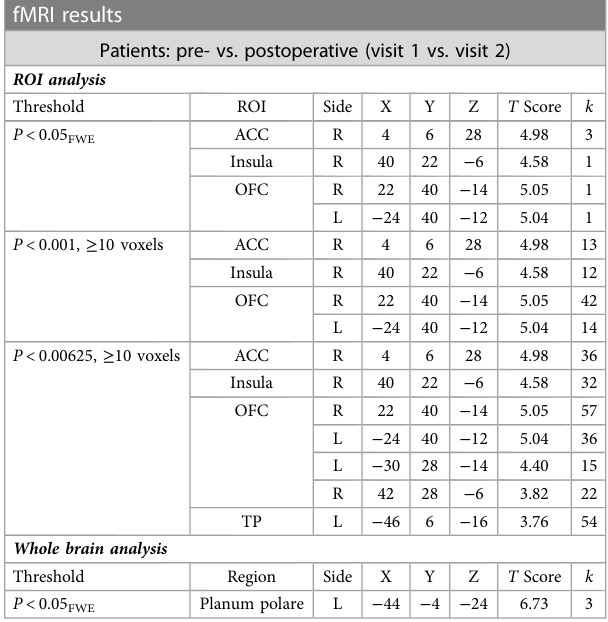
TABLE 5B Clusters of increased BOLD signal after surgery within the patient group (visit 1 vs. 2) (signi fi cant results shown at each threshold level in order to demonstrate corresponding cluster size).